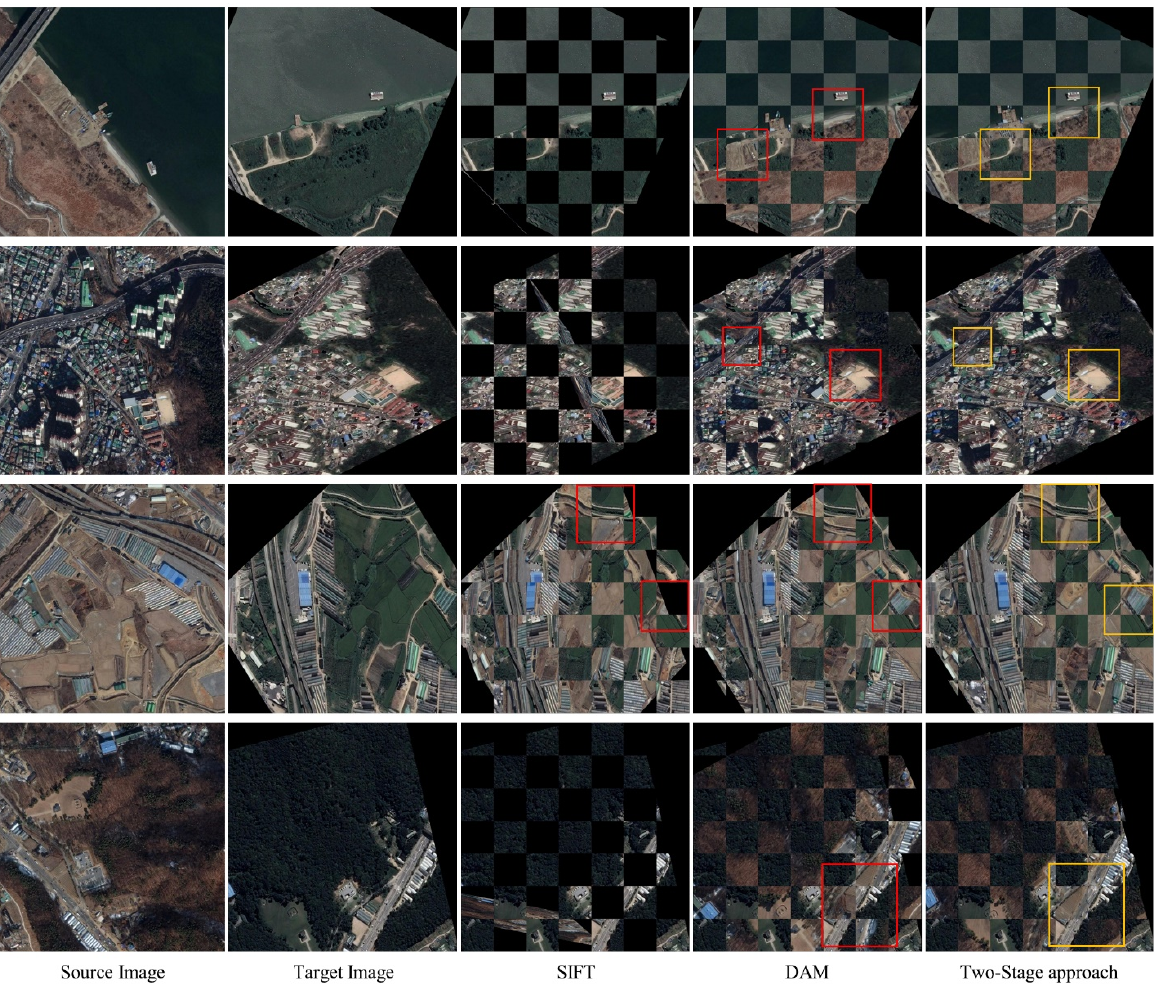
Figure 14. Comparison of qualitative registration results. Rows are pair 1 – 4 respectively. The alignment results are displayed in the form of checkerboard overlays. Significant local details are marked with red boxes and yellow boxes in the results of other methods and ours, respectively. Table 9. Comparison of quantitative results. Columns 1~4 represent the errors of registration for pair 1–4 in Figure 14 respectively. “\” represents the failure of registration. MAE: Mean absolute error.